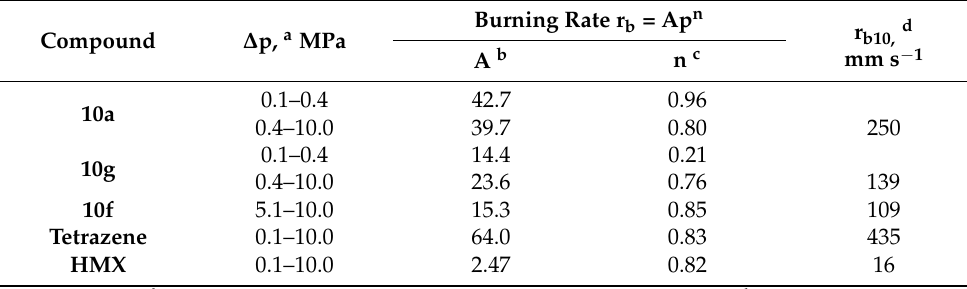
Table 3. The combustion parameters of perchlorates and benchmark compounds. Compound